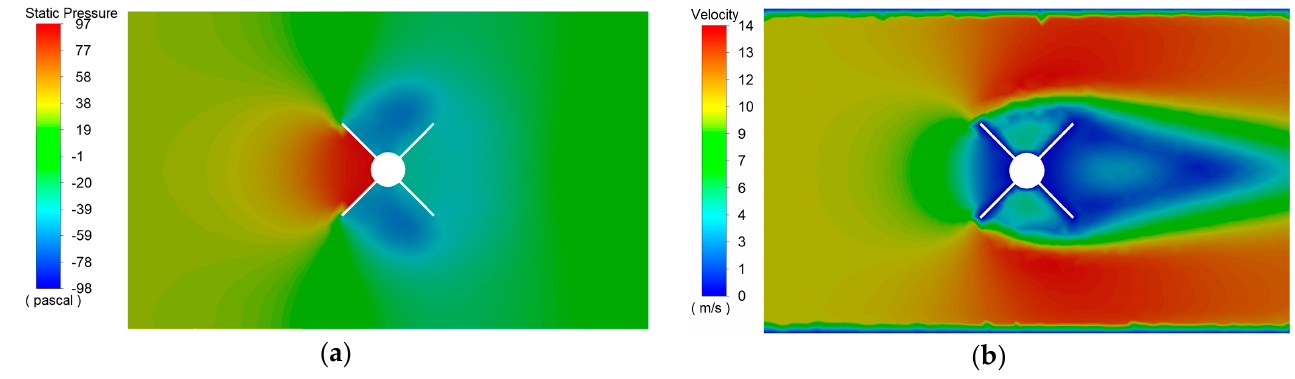
Figure 12. ( a ) Pressure distribution; ( b ) Velocity distribution for the tube with 4 fins (case c4).